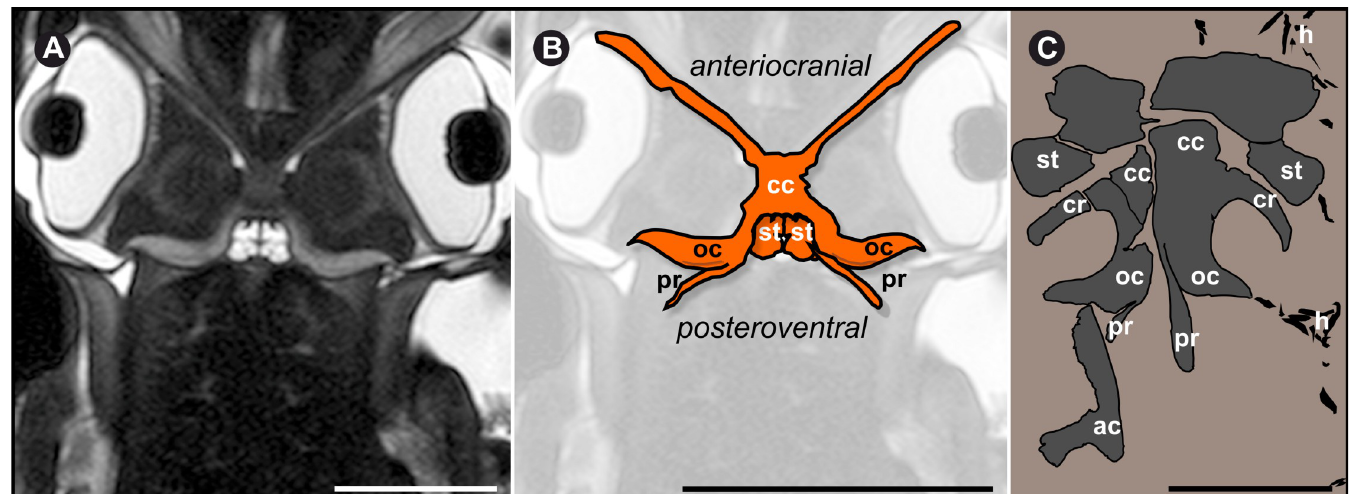
Fig 8. Homologization of fossil specimens with modern coleoid cartilage. (A) MRT-data [46] of Sepia officinalis . Note the hook-like ending and angle to the C structure. Scale bar 20 mm. (B) 2D-Drawing of cartilage, redrawn magnified from a, showing principal shape of the structure in S . officinalis . Scale bar 2 cm. (C) Digital drawing of most entire specimen (NHMW 2021/0123/0057) obtained during excavations in 2021, with suggested elements as labeled: ac arm cartilage, cc cephalic cartilage, cr carrier, h hooks, oc ocular cartilage, pr processus, st statocysts. Scale bar 1 cm.